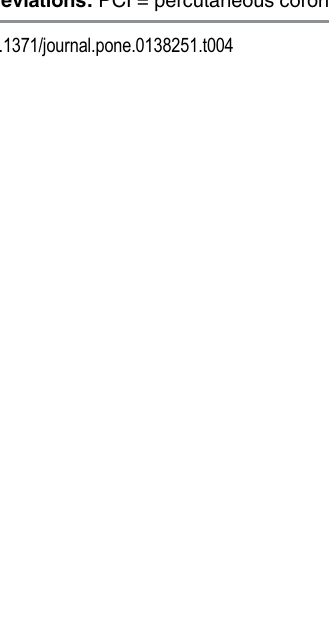
Table 4. In-hospital mortality rates by quintile of PCI rate. All